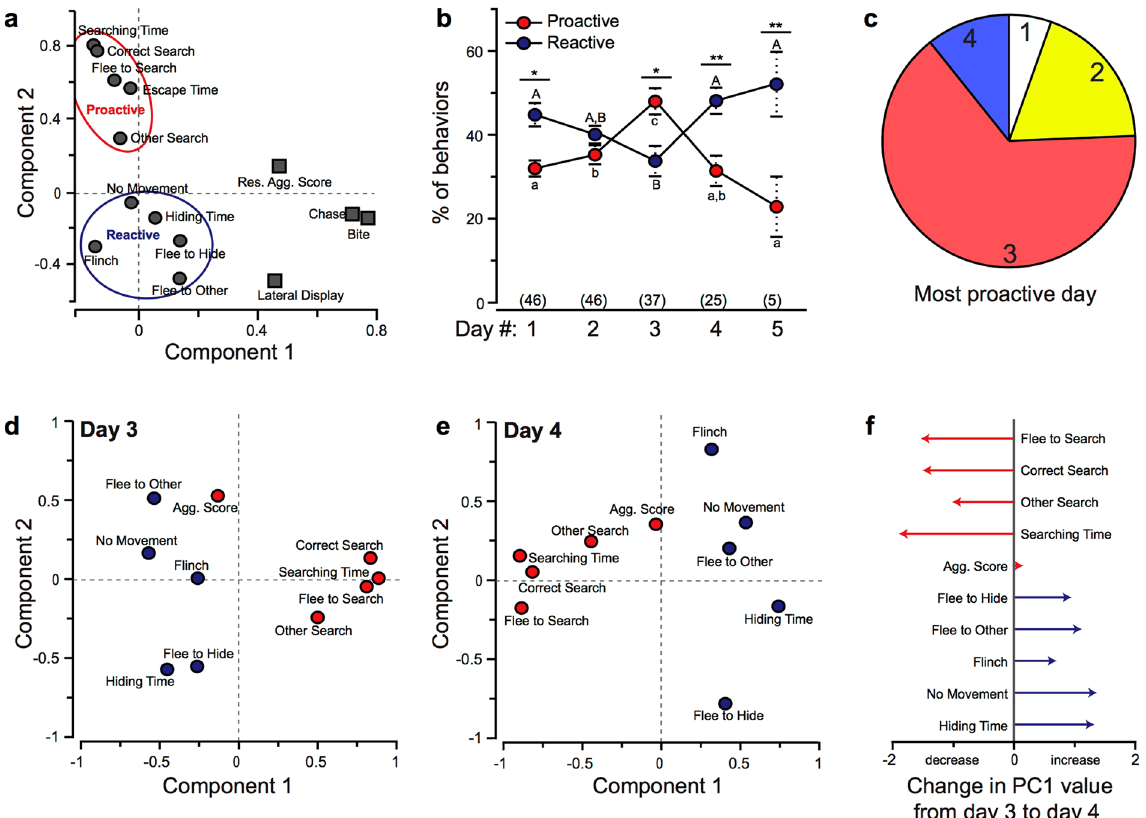
Figure 3. Astatotilapia burtoni males switch between reactive and proactive coping behaviours following repeated social defeat from the same aggressor. ( a ) A principal component analysis was used to classify behaviours as either proactive or reactive. Component 1 primarily distinguished resident behaviours (squares) while component 2 was related to intruder behaviours (circles). Behaviours with a positive loading value on component 2 were classified as proactive while negatively loaded values were classified as reactive. ( b ) Use of reactive and proactive coping behaviours changes with the number of defeat interactions. Proactive behaviours (red) peak on day 3 of repeated social defeat, but fish quickly return to using reactive behaviours (blue). Numbers in parentheses represent sample size. Different upper- and lower-case letters indicate differences in reactive and proactive behaviours, respectively, across days. Asterisks indicate difference between proactive and reactive behaviours each day. ( c ) The majority of animals had their most proactive trial occur on day 3, but ~30% were most proactive on days 1, 2, or 4 of repeated social defeat. ( d , e ) A PCA of intruder behaviours on day 3 ( d ) and day 4 ( e ) of repeated social defeat represents the relative use of each behaviour, where more frequently used behaviours load positively into PC1. ( f ) The difference between PC1 values of each individual behaviour from day 3 to day 4 indicates the degree of change between the